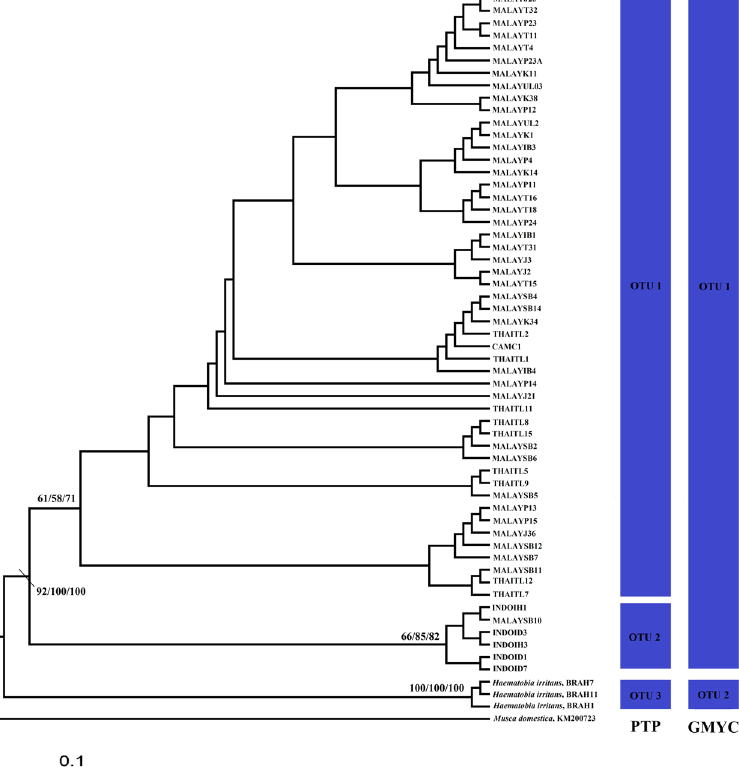
Figure 2. Bootstrap [maximum likelihood (ML)/maximum parsimony (MP)/ neighbour-joining (NJ)] values are shown on the branches. Values less than 50 are not shown. The scale bar represents 0.1 substitutions per nucleotide position. The blue columns on the right show numbers of operational taxonomic units (OUTs) identified by the species delimitation analyses.